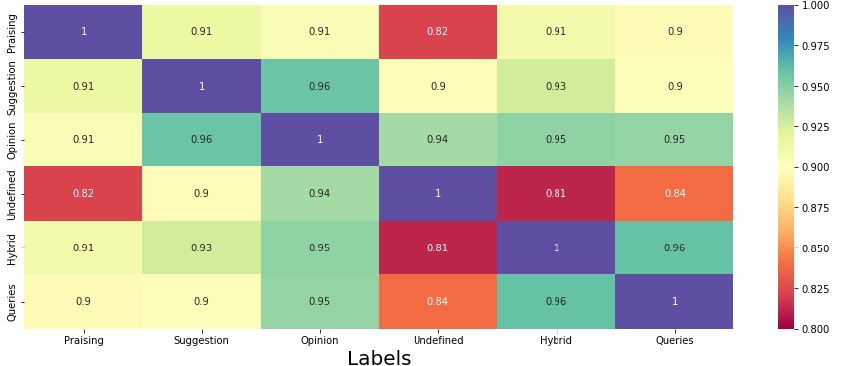
Figure 7. Correlation heatmap between assigned